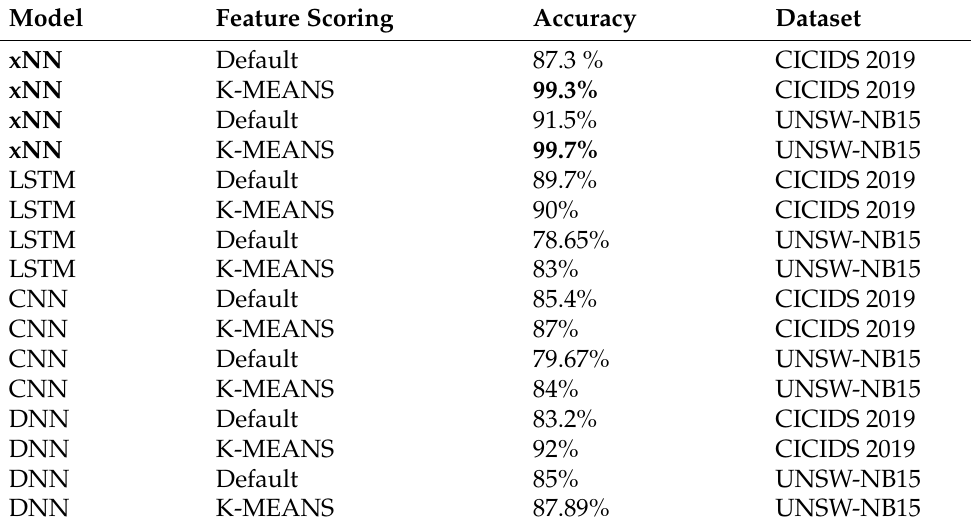
Figure 17. Comparison of the deep-learning model on the CICIDS2019 dataset. Table 4. Comparative analysis of the deep-learning models.